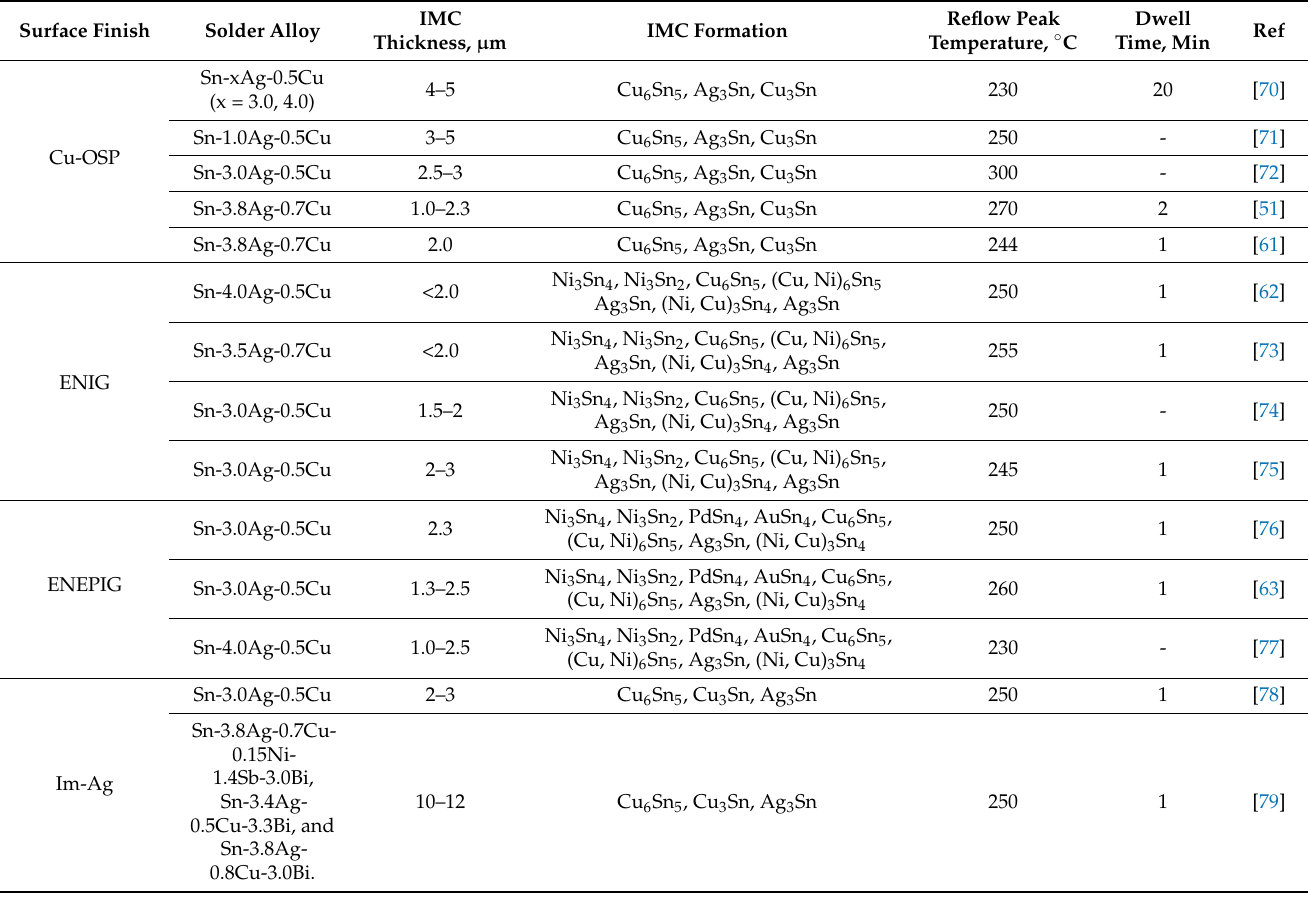
Table 2. The Sn-Ag-Cu IMC thickness on the different surface